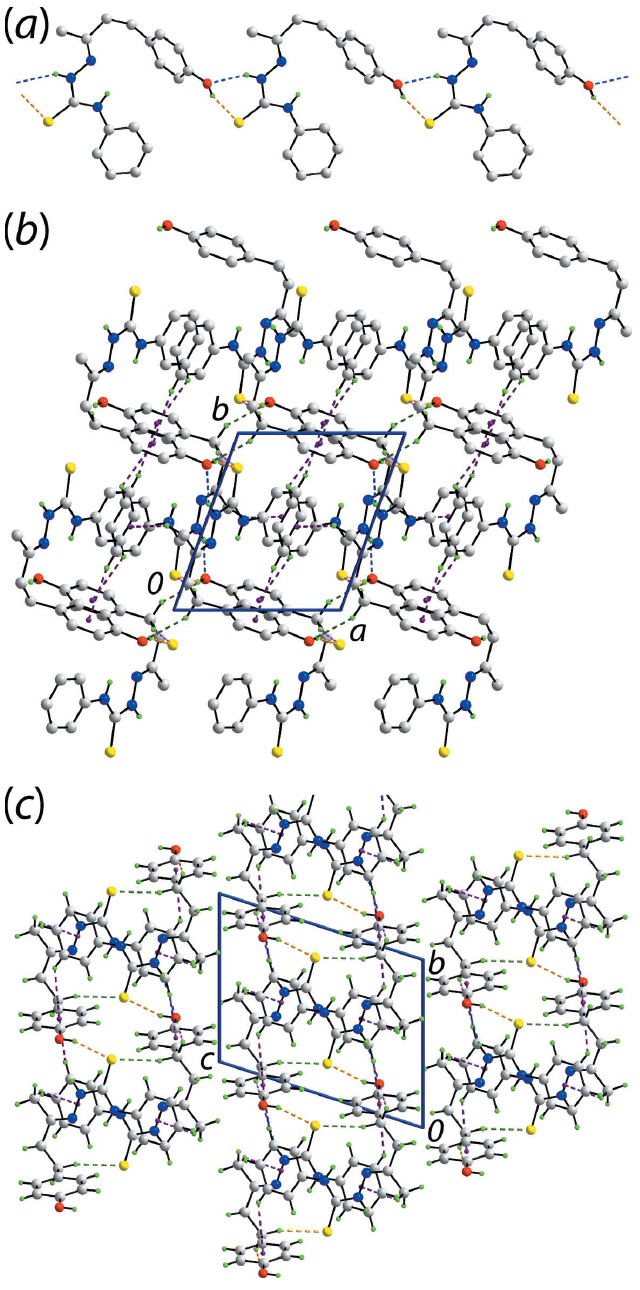
Figure 2 Molecular packing in (I): ( a ) the supramolecular chain sustained by hydroxy-O—H (cid:4)(cid:4)(cid:4) S(thione) and amine-N—H (cid:4)(cid:4)(cid:4) O(hydroxyl) hydrogen bonding shown as orange and blue dashed lines, respectively (non- participating H atoms omitted), ( b ) the supramolecular layer whereby the chains of ( a ) are connected by methylene-C—H (cid:4)(cid:4)(cid:4) O(hydroxy) (pink dashed lines), methylene-C—H (cid:4)(cid:4)(cid:4) O(thione) (green) and C—H (cid:4)(cid:4)(cid:4) (cid:2) (purple) interactions (non-participating H atoms omitted) and ( c ) a view of the unit-cell contents shown in projection down the a axis highlighting the stacking of layers. atoms, correspond to the amine-N2—H2 N (cid:4) (cid:4) (cid:4) O1(hydroxyl), hydroxyl-O1—H1 O (cid:4) (cid:4) (cid:4) S1(thione) hydrogen bonds and the thione-S1 (cid:4) (cid:4) (cid:4) S1(thione) short contact; these and other short contacts calculated using Crystal Explorer 17 are collated in